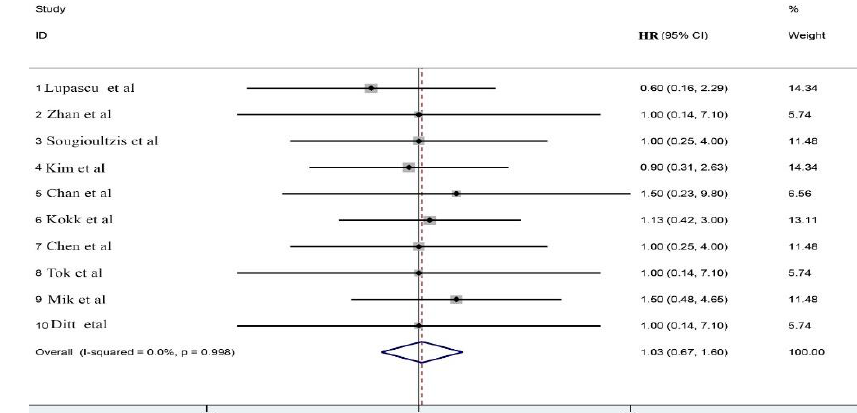
Fig. 2. Forest plots showed Hazard ratio for overall